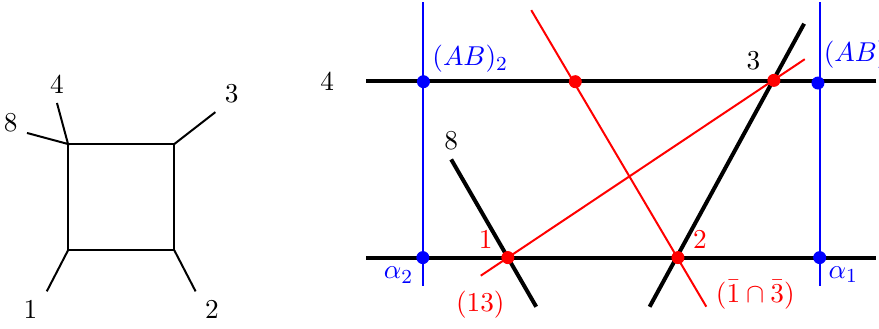
Figure 1 . One-mass configuration (left) and four points on the line (12) (right); the black lines (81) , (12) , (23) and (34) form a one-mass Schubert problem, whose solutions are the red lines, intersecting (12) at 1 and 2 ; blue lines ( AB ) 1 and ( AB ) 2 are the solutions from the four-mass Schubert problem, intersecting with (12) at α 1 and α 2